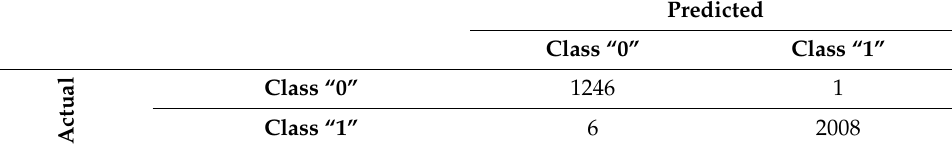
Table 3. Confusion matrix for J48